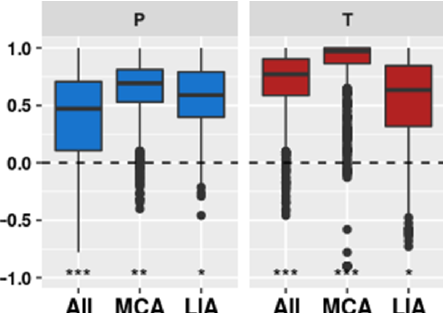
Figure 4. Within-ensemble correlations. Correlations between 1000 pairs randomly chosen from the precipitation (blue) and tem- perature (red) ensembles. Box plots encapsulate the space between the first and third quartile with the median shown as a black line; whiskers indicate the 95% confidence interval of the median; points are values outside this confidence interval (outliers). Statistical sig- nificance of the median value is indicated at the bottom: ∗∗∗ p < 0 . 001, ∗∗ p < 0 . 01, ∗ p < 0 . 05, ^ p < 0 . 1, p > 0 . 1.